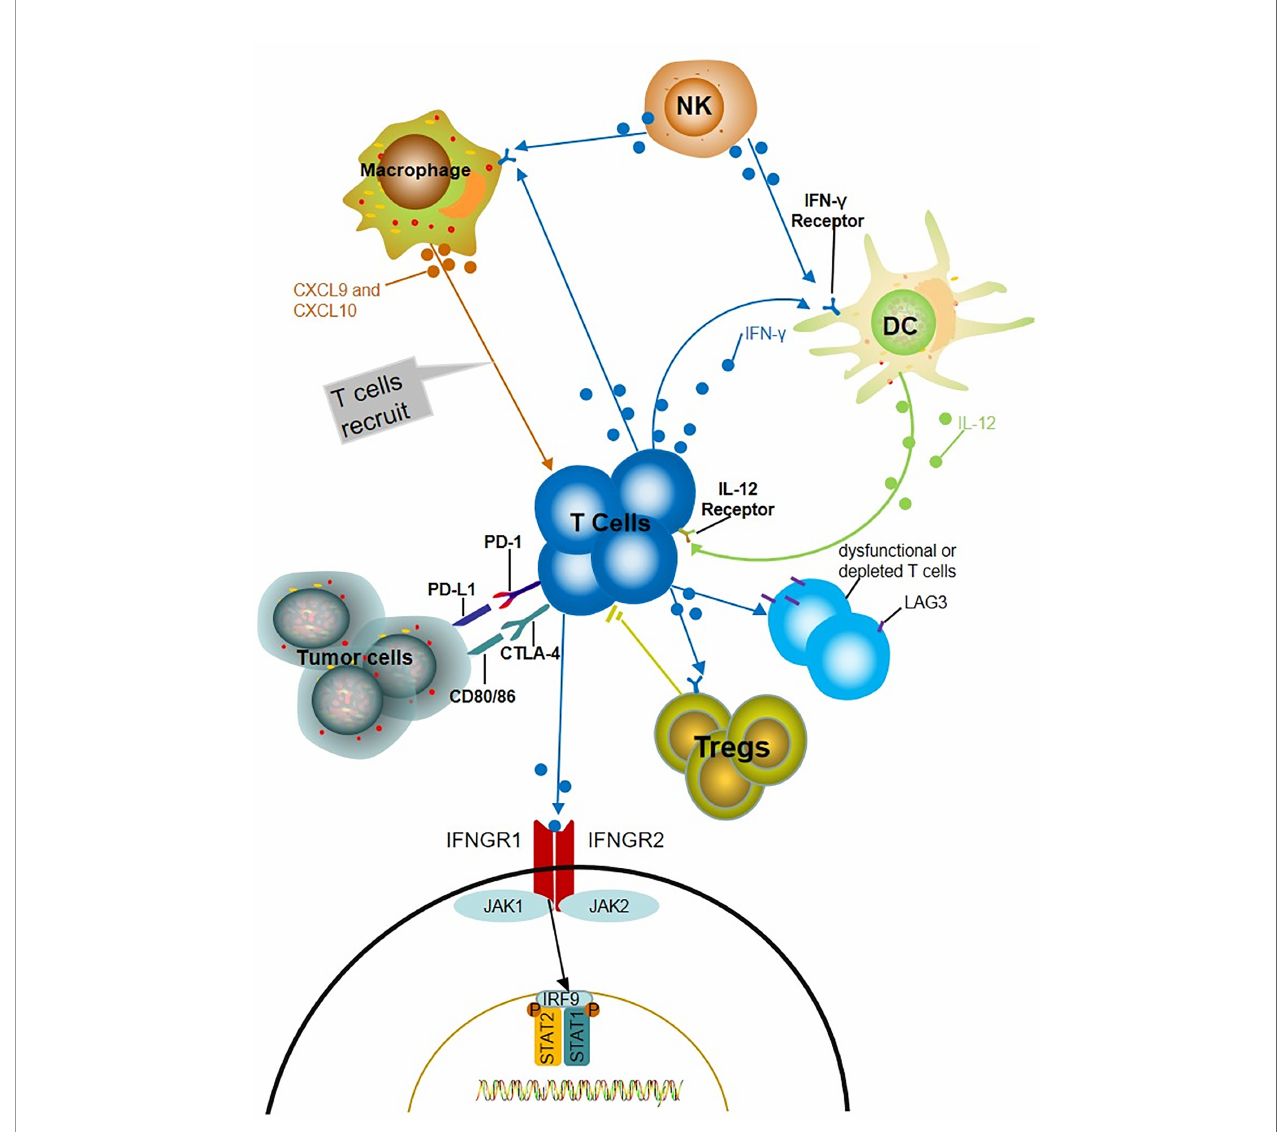
FIGURE 1 | Potential mechanisms of IFN- g predicting the prognosis of ICIs. The production of IFN- g induces the increase of chemokine CXCL9 and CXCL10, which recruits more tumor reactive T cells and increased the level of IFN- g . IFN- g released by T cells stimulates neighboring dendritic cells (DCs) to produce IL-12, which in turn promotes the production of IFN- g and forms a positive feedback loop. IFN- g induces LAG3 which mainly express on dysfunctional or depleted T cells and induce immunosuppression. The fragility of Treg driven by IFN- g produced by intratumoral Nrp1-/- treg limits the activity of CD4+Treg